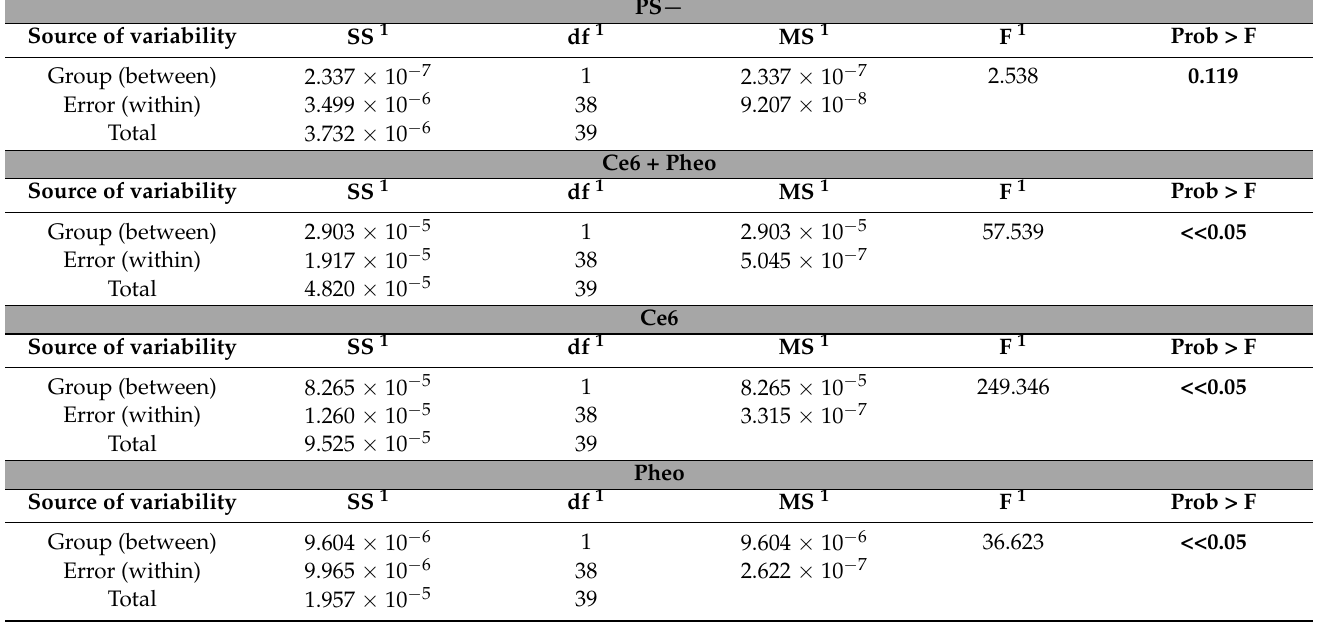
Table 2. The results of the ANOVA, where each from 2 groups represent the set of average RI of